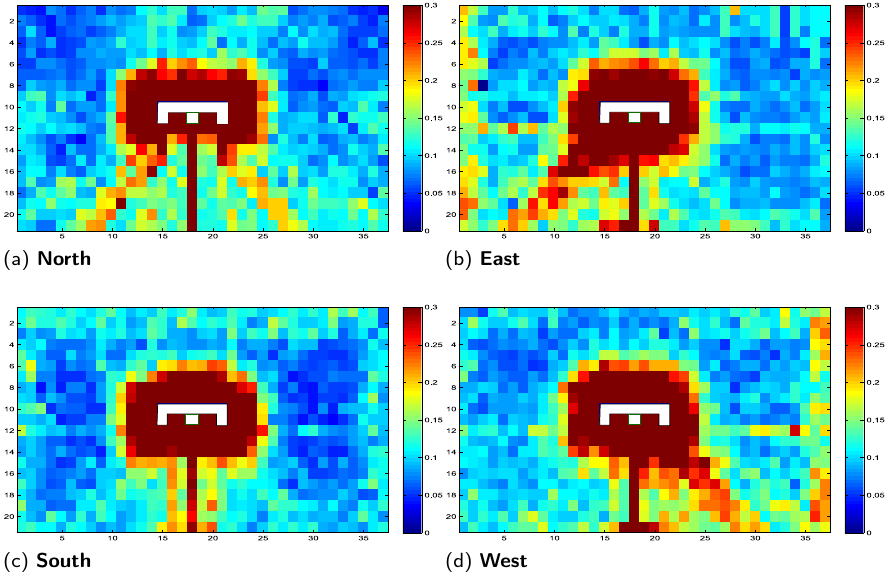
Figure 10. Heat-maps show the overfitting performance of each potential training instance’s starting point. Blue cells indicate areas where GE tends to produce better general controllers, whereas red cells indicate areas where GE tends to produce less effective general